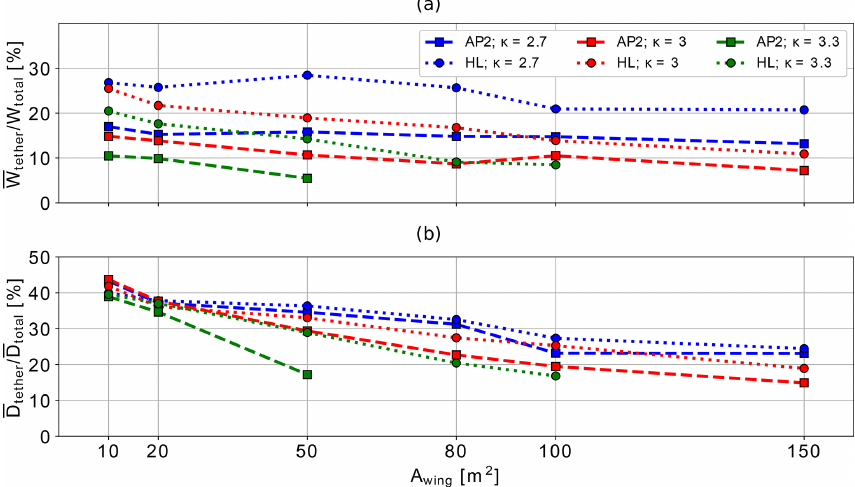
Figure 13. Percentage of cycle-average tether weight W tether to total weight of airborne components W total (a) and tether drag D tether to total drag D total (b) during production phase (reel-out), averaged over the entire wind speed range for all aircraft sizes A = 10–150m 2 , sets of aerodynamic coefficients AP2, HL and mass-scaling exponents κ = 2 . 7, 3, 3.3 for wind data at the offshore